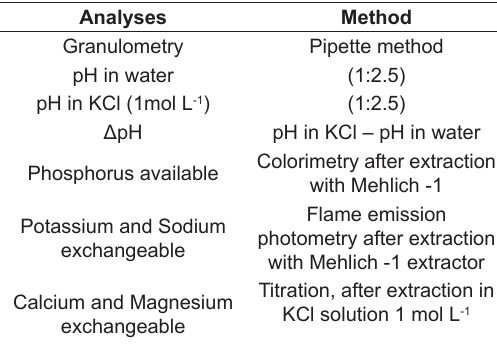
Table 1. Analyzes and methods used for the characterization of adsorbents